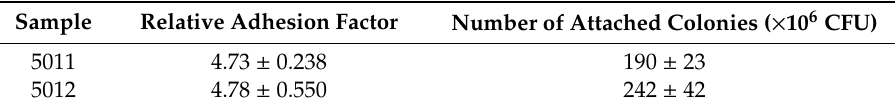
Table 6. Relative adhesion factors and number of attached